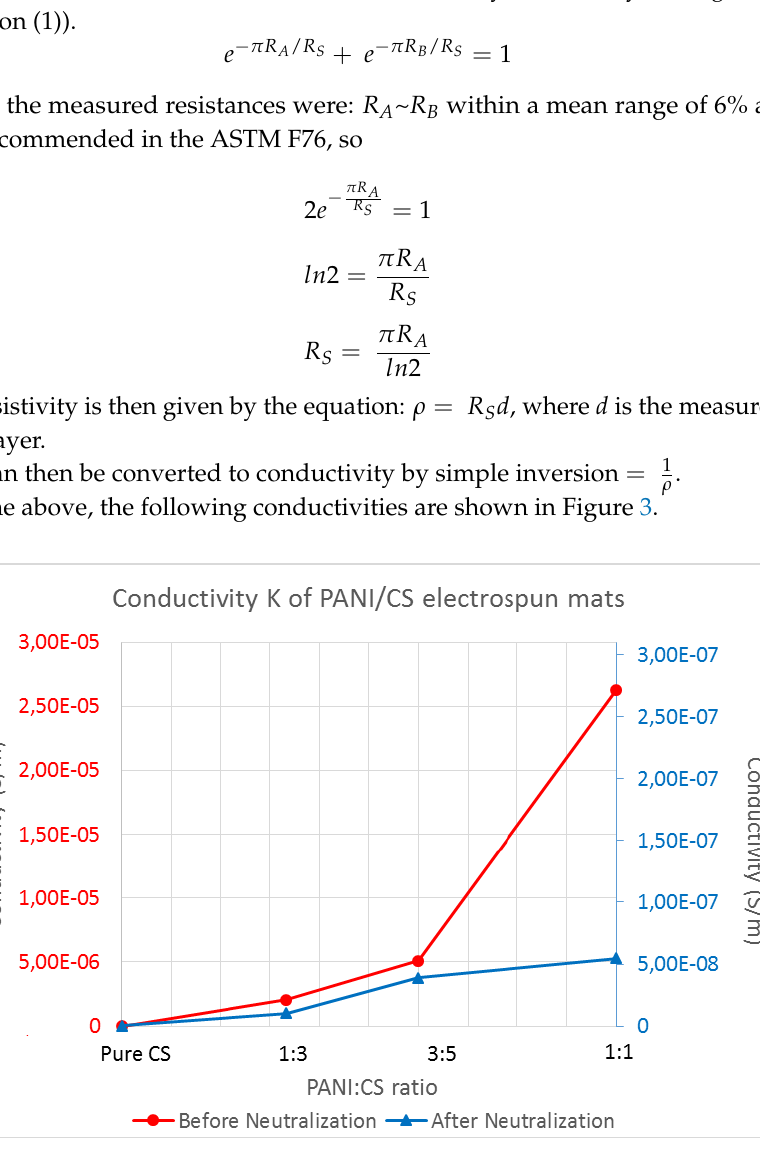
Figure 3. Comparison chart of membrane conductivity before and after neutralization (note the different order of magnitude for the two curves).